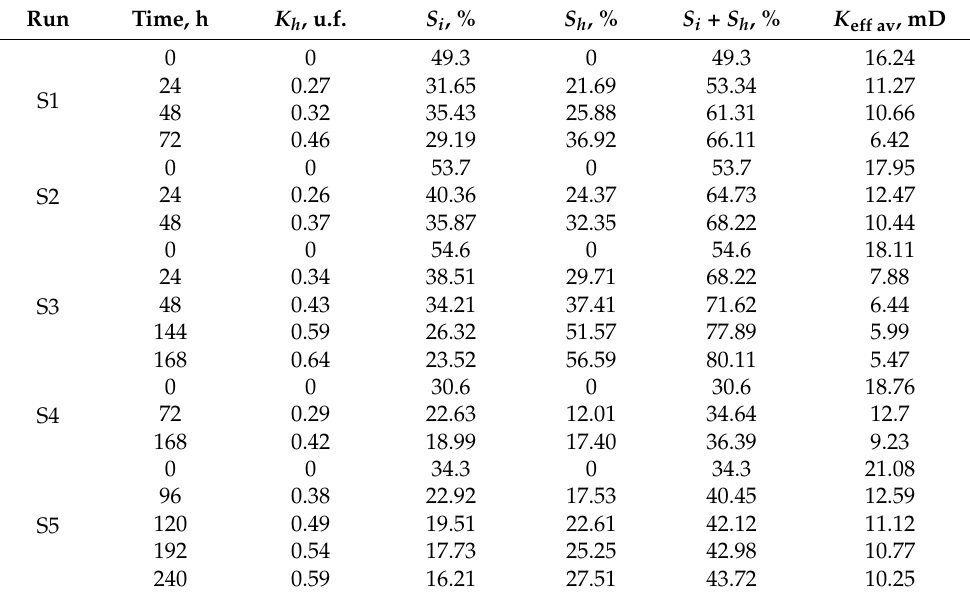
Table 3. Properties of frozen sand samples during hydrate formation at constant negative temperature ( − 5 ◦ C).